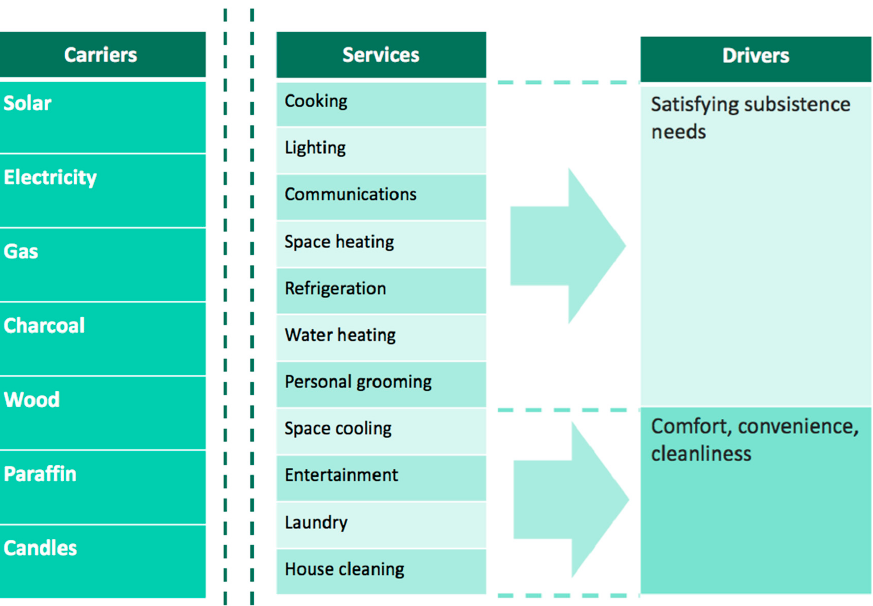
Figure 5. Conceptualization of Cape Town’s household energy flows .